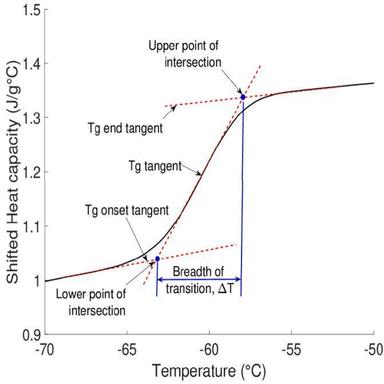
Illustrating how the breadth of transition is defined.